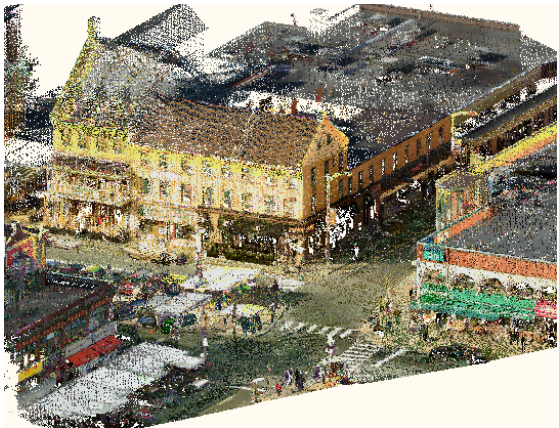
Figure 4: Typical example of an urban